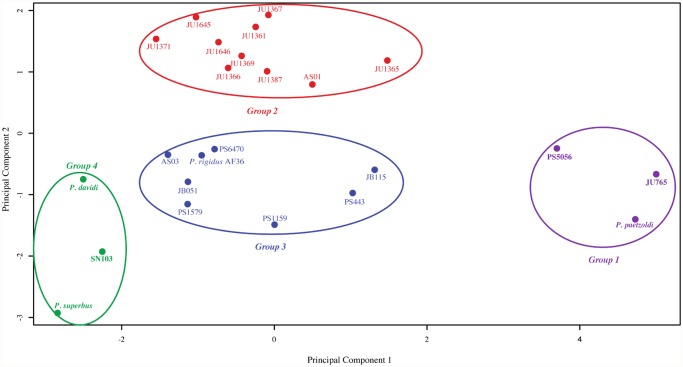
Principal component analysis of the desiccation and freezing survival data for 24 Panagrolaimus strains.The distribution of the strains in the plane formed by Principal Component 1 and Principal Component 2 is shown. These components, which correspond respectively to 57.34% and 24.86% of the variance, discriminated between four phenotypic groupings.